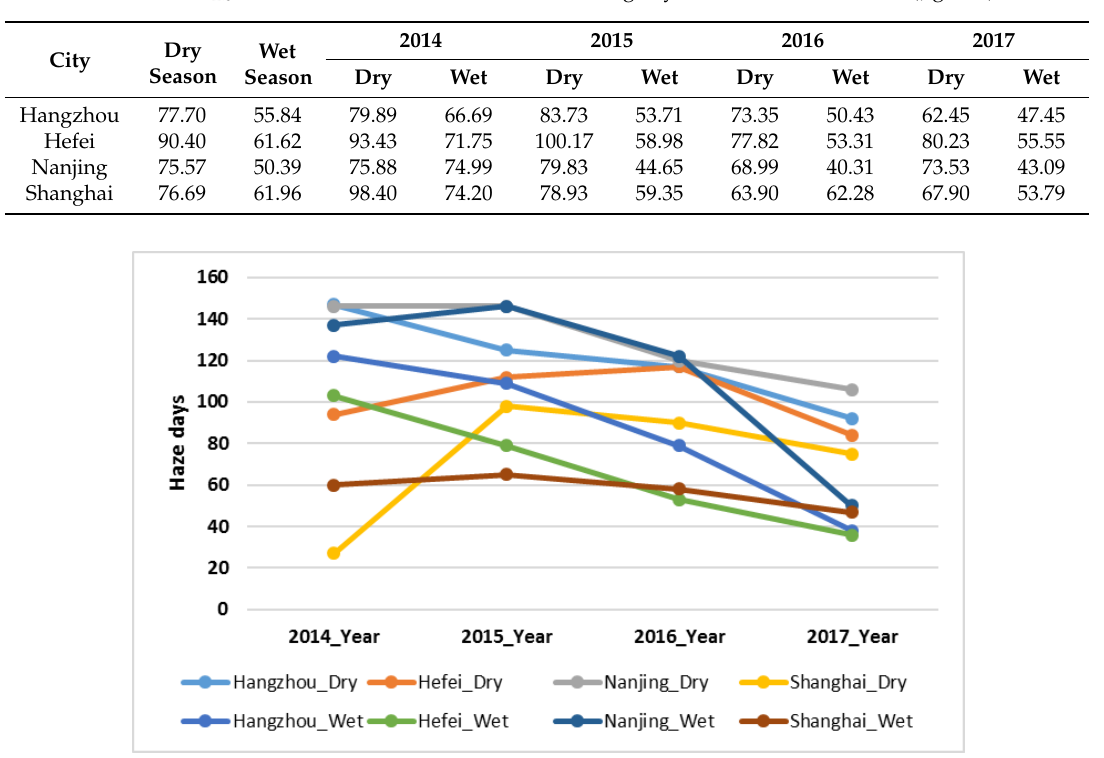
Table 2. PM 2.5 concentration in four main cities during dry season and wet season ( μg/m 3 ).